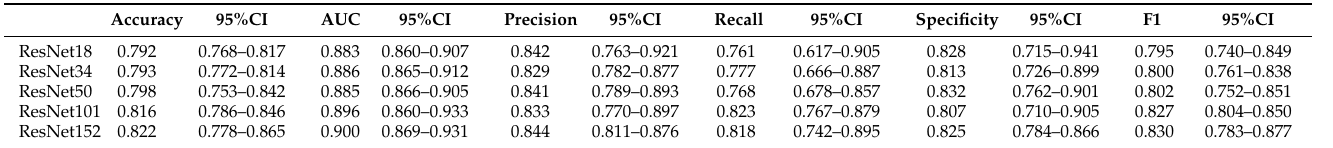
Table 2. Prediction performance of hip radiographic images only models.